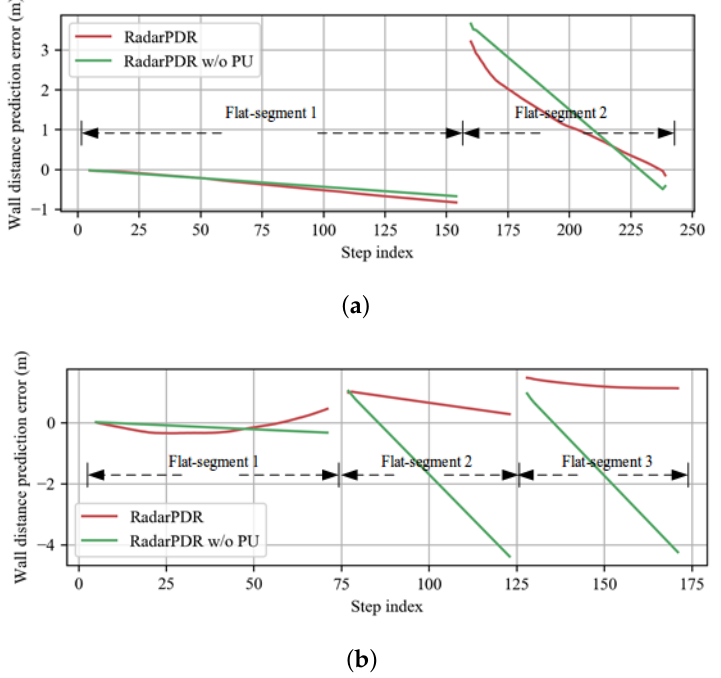
Figure 11. Wall distance prediction error. ( a ) average WDPE of all the testing trajectories on the L-shape route; ( b ) average WDPE of all the testing trajectories on the Z-shape